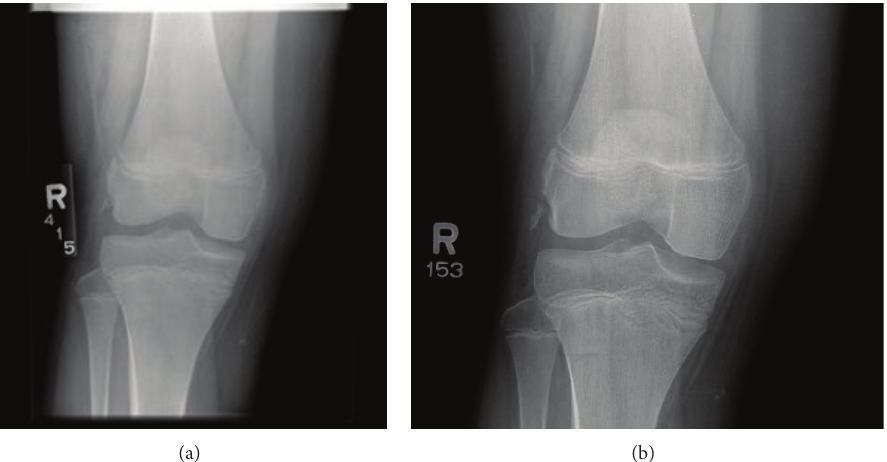
Figure2:(a)APradiographshowingavulsionfractureintheareaofthepopliteustendon.(b)6-weekfollow-upradiographshowingpersistent fragment